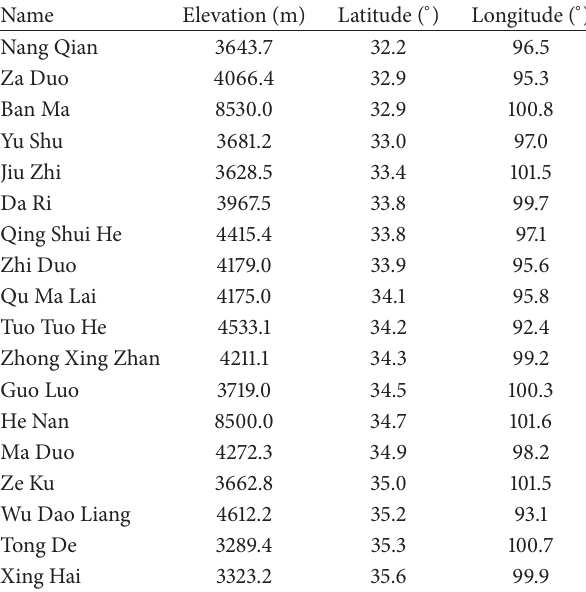
Table 1: The distribution of national meteorological stations within the study area.